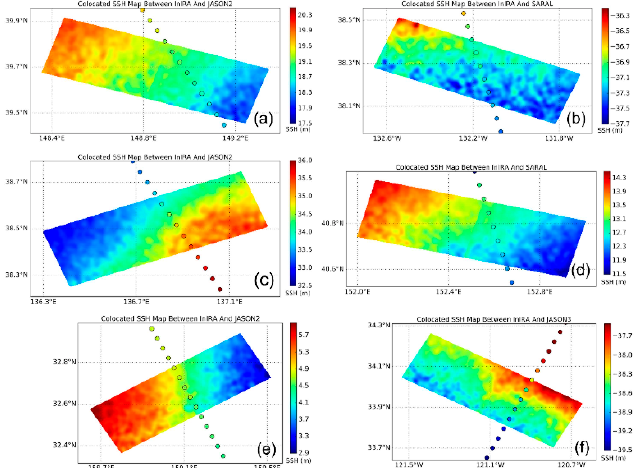
Figure 3. All colocated sea surface height (SSH) maps of the Interferometric Imaging Radar Altimeter (InIRA) and traditional altimeters, except for the case described in Figure 2. ( a ), ( c ), and ( e ) show colocations with Jason-2, ( b ) and ( d ) show colocations with Saral/AltiKa, and ( f ) shows colocations with Jason-3.